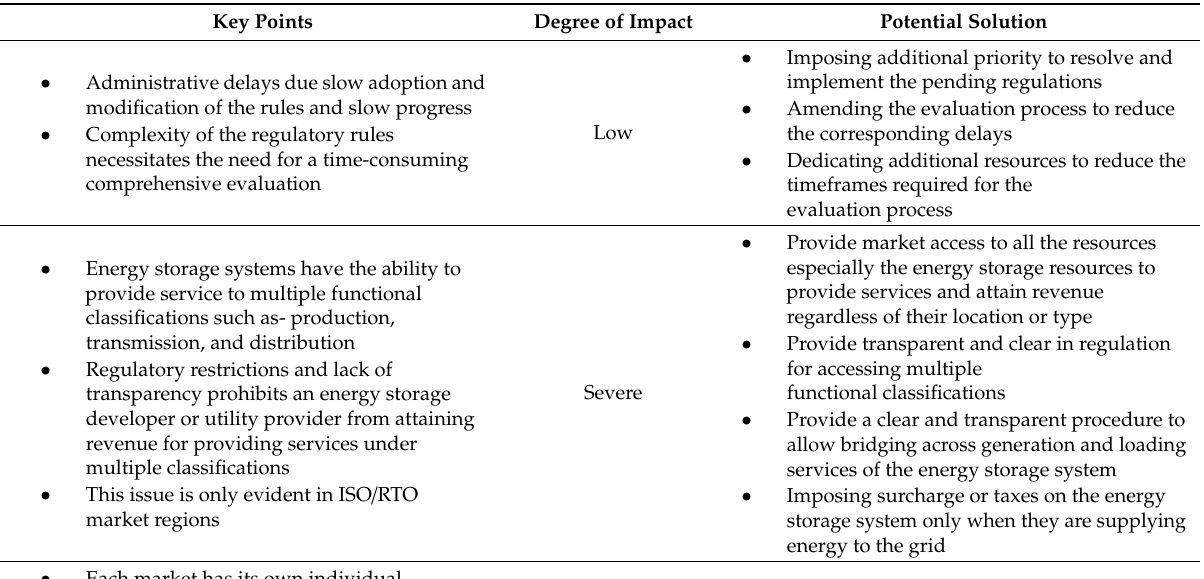
Table 23. Di ff erent types of barriers of ESS, the issues they introduce, their degree of impact, and the potential solution of overcoming these issues [340].